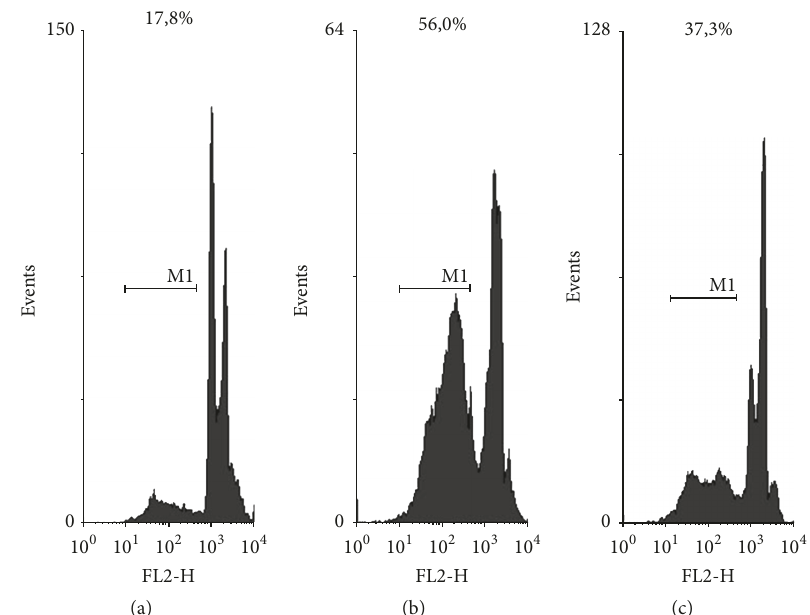
Figure 6: Histograms of distribution of U937 cells in content of DNA with the influence of cisplatin in solution or in conjunction with dextran containing nanoparticles: (a) control; (b) cisplatin solution of 3 𝜇 mol/L; (c) nanocontainers loaded with cytotoxic chemotherapy drugs cisplatin, 3 𝜇 mol/L.